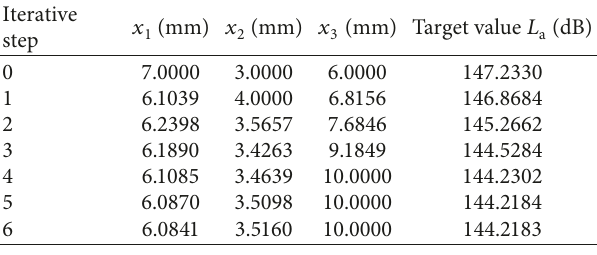
Table 6: Results of each iteration.